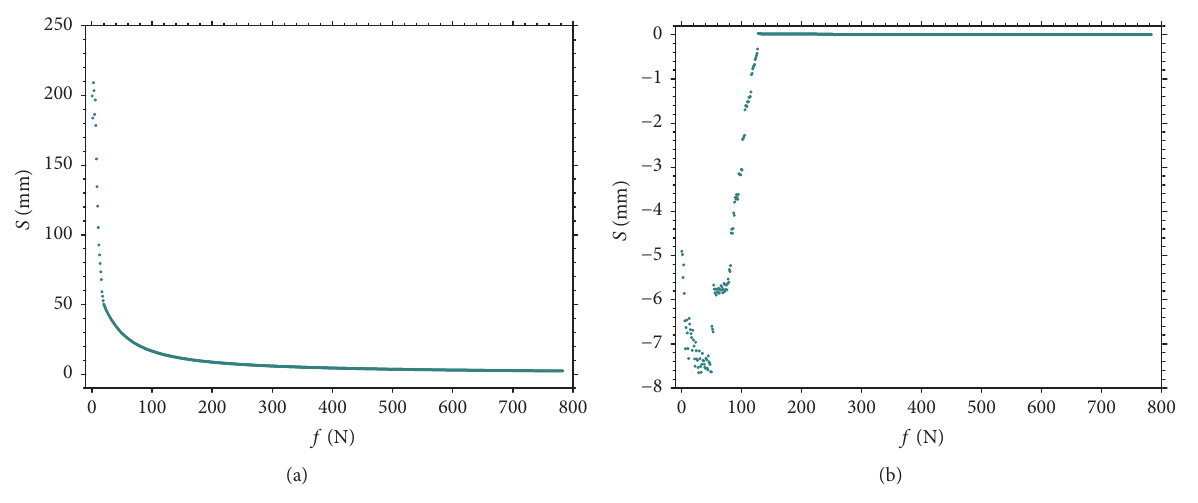
Figure 10: The displacement curvewith friction force: the relationship of the 𝑆 with 𝑓 : (a) the forward displacement curvewith friction force; (b) the backward displacement curve with friction